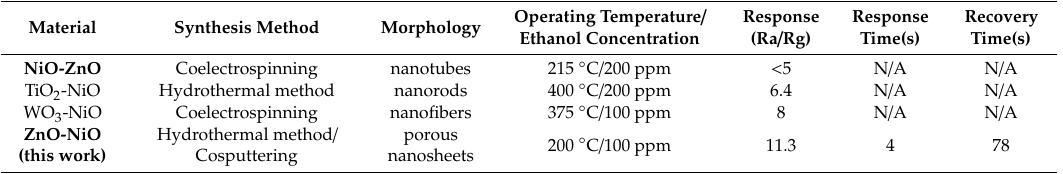
Table 1. Comparative ethanol vapor sensing performance of various p-n composites comprised with NiO synthesized via various synthesis routes